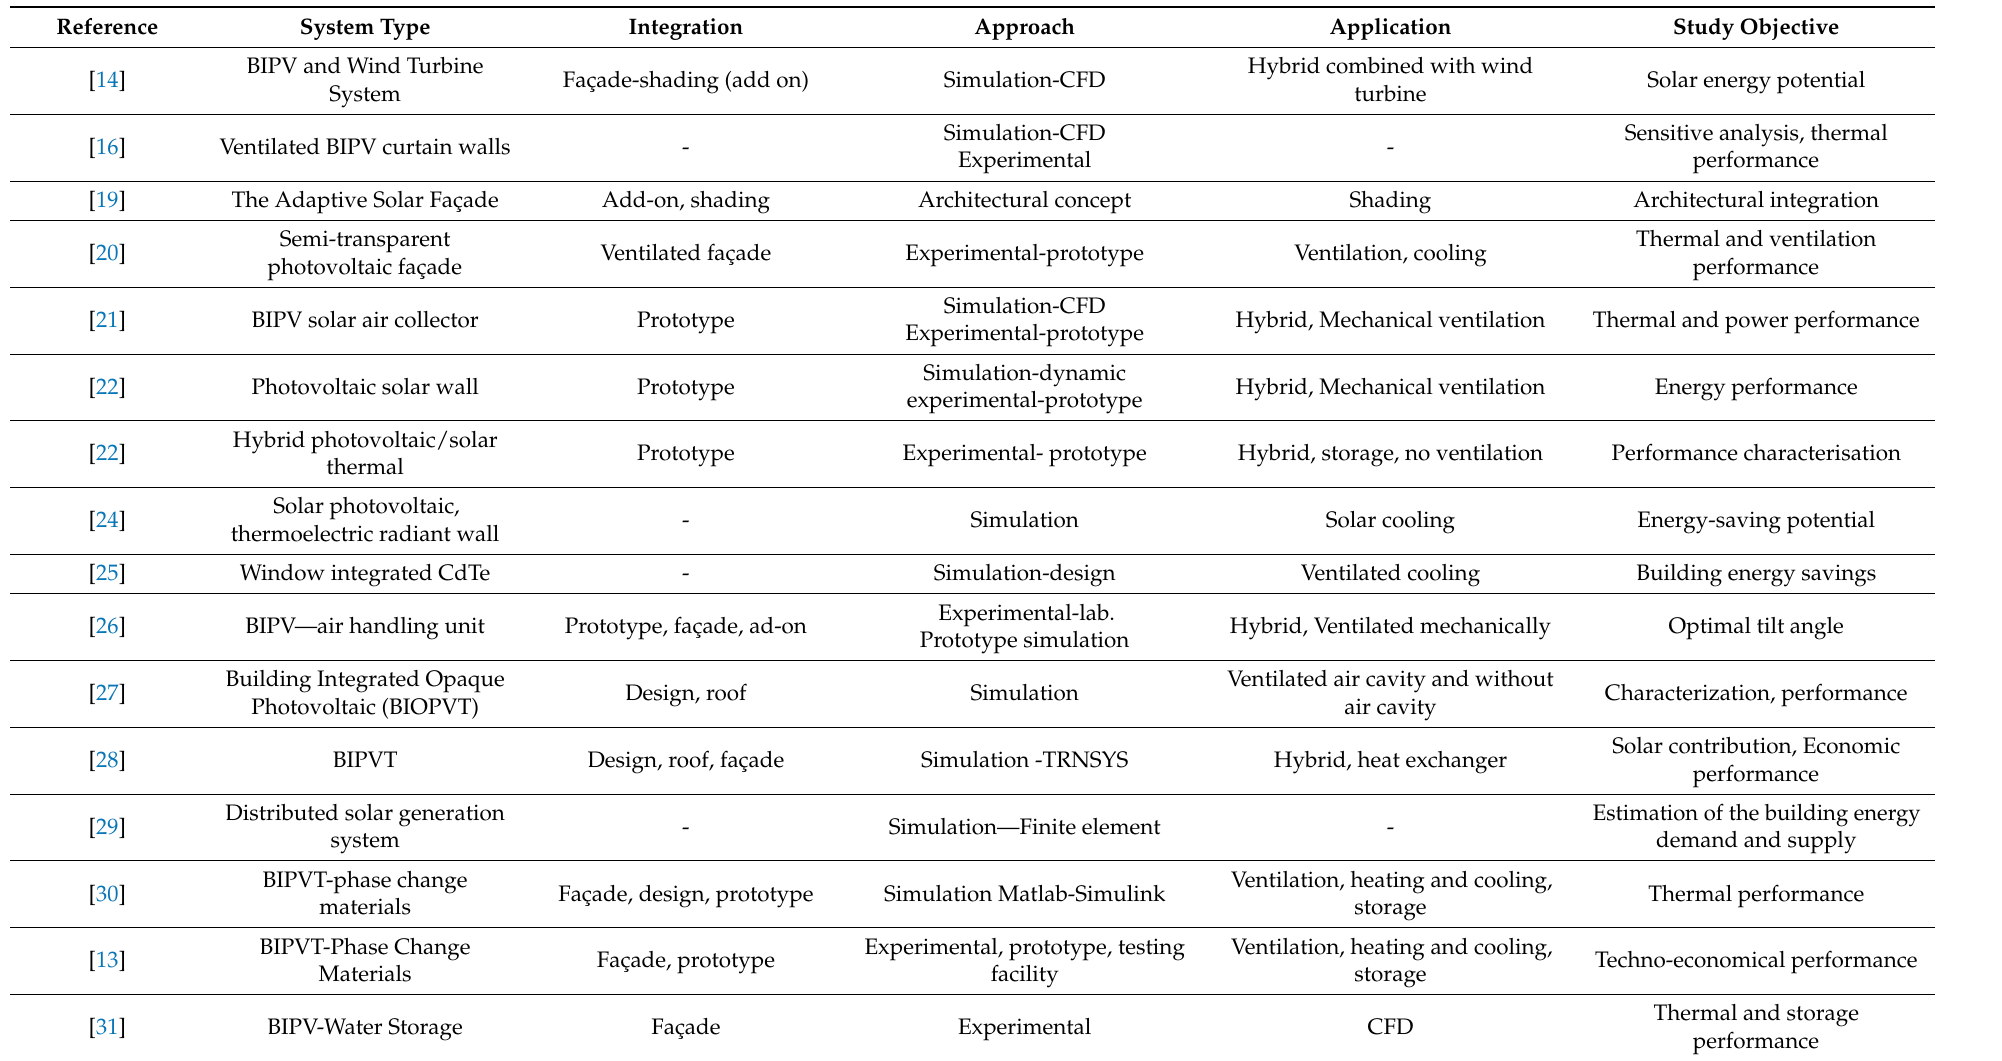
Table 1. Summary of related